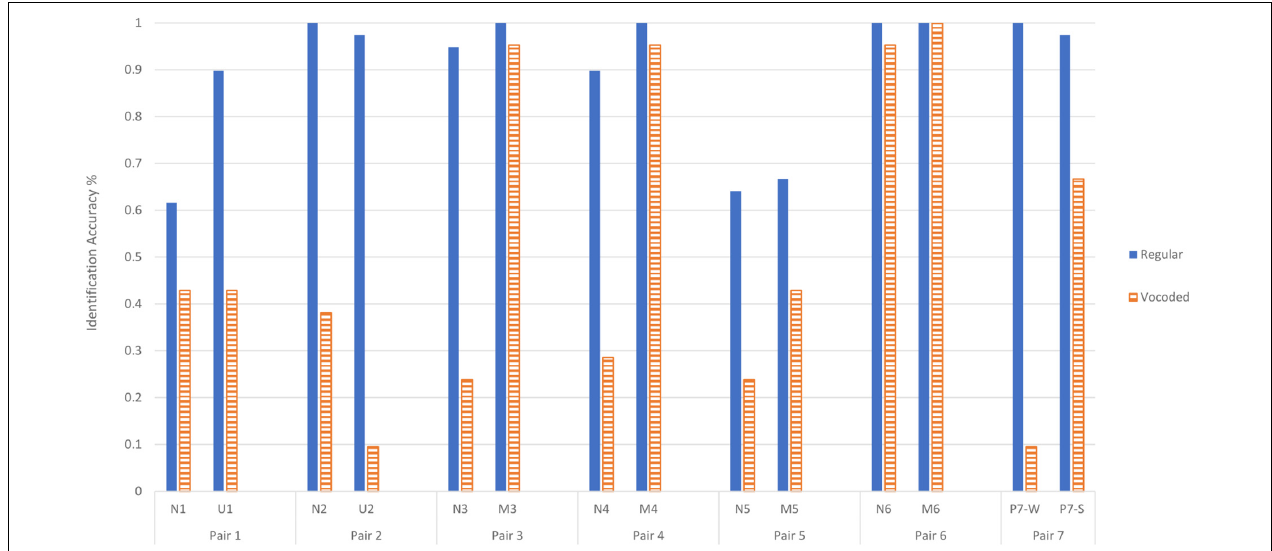
FIGURE 4 | Mean identification accuracy for each of the fourteen sounds in their pairs for regular sounds in Experiment 1 (solid blue bars) and vocoded sounds in Experiment 2 (striped, orange bars). Each sound name is replaced with its pair label, with P7-W denoting Wind flowing and P7-S denoting Stream flowing. The higher the identification accuracy for a particular sound, the higher on the y axis it is